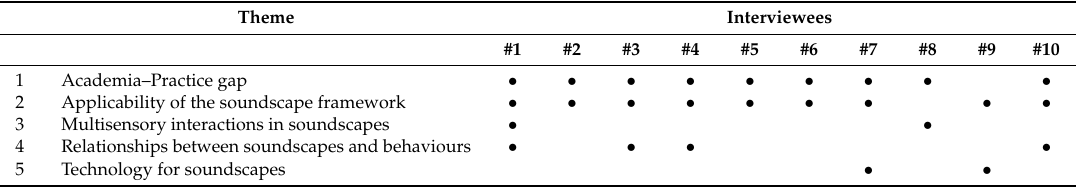
Table 2. Occurrence of the identified themes among the ten